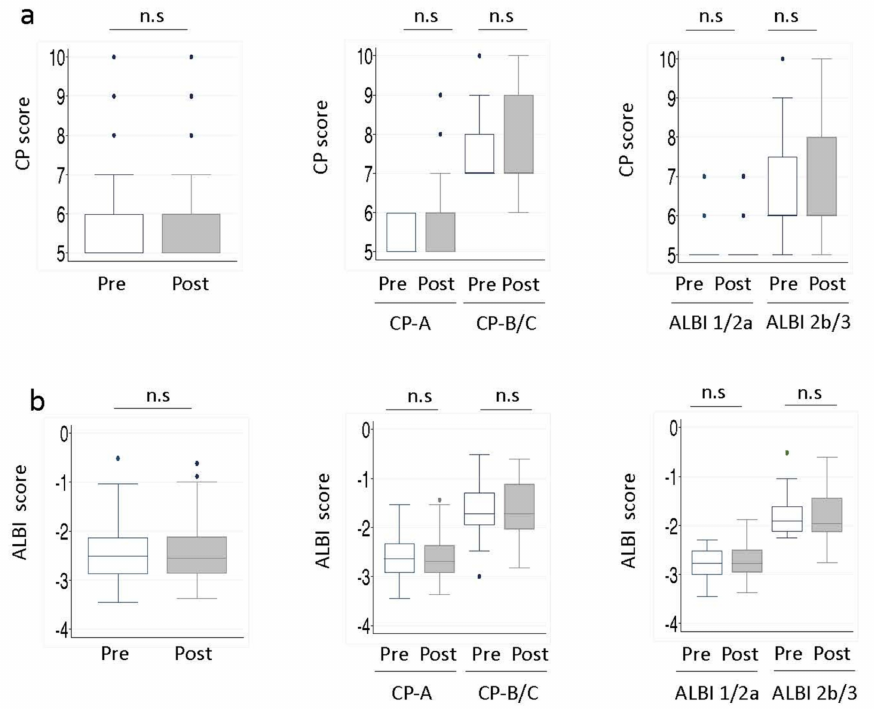
Figure 1. Changes in the liver function reserve after vaccination. ( a ) Child–Pugh (CP) score in all patients with cirrhosis ( left , n = 111), CP class A (n = 91) and B/C (n = 20) ( middle ), and ALBI grade 1/2a (n = 82) and 2b/3 (n = 42) ( right ). ( b ) Liver function reserve as assessed by the ALBI score in all patients with cirrhosis before and after vaccine ( left , n = 124), CP class A and B/C ( middle ), and ALBI grade 1/2a and 2b/3 ( right ). n.s.: not